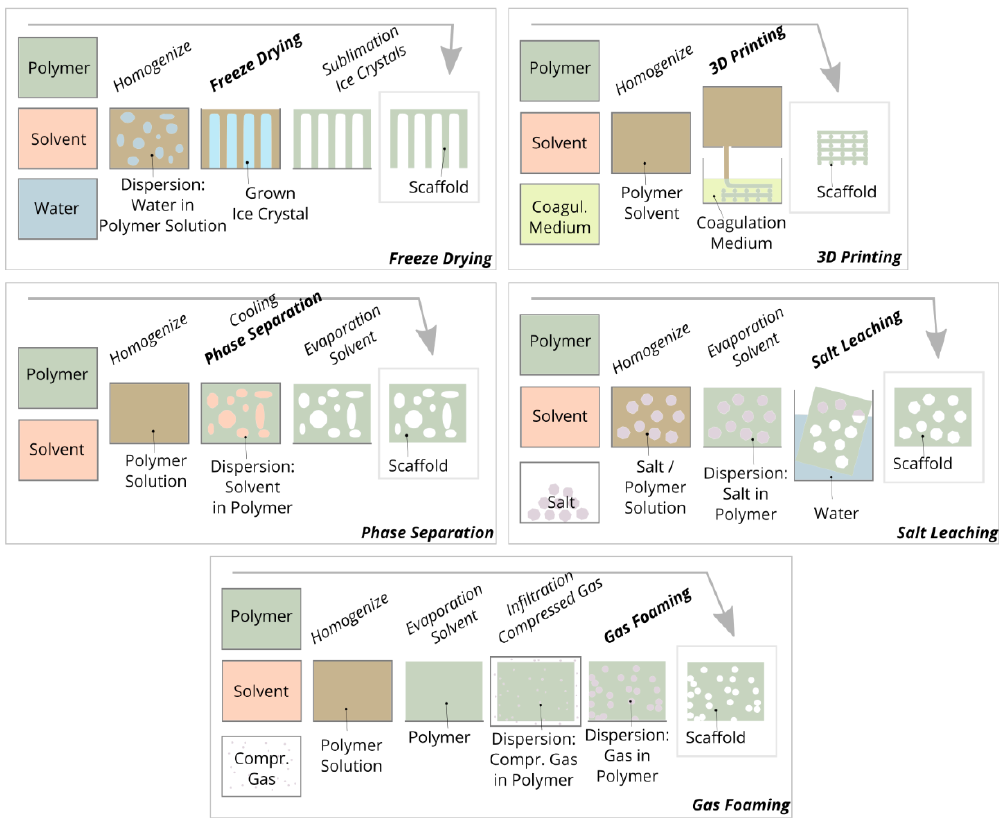
Figure 4. Schematic representation of the five main conventional fabrication methods of scaffolds.